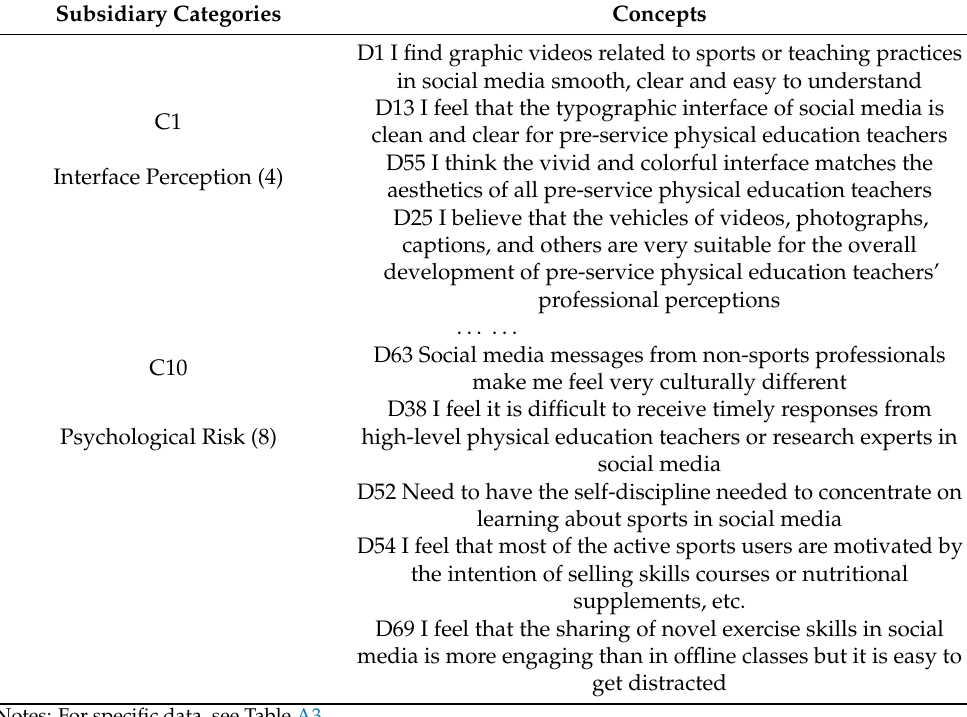
Table 5. Results of categorization of 70